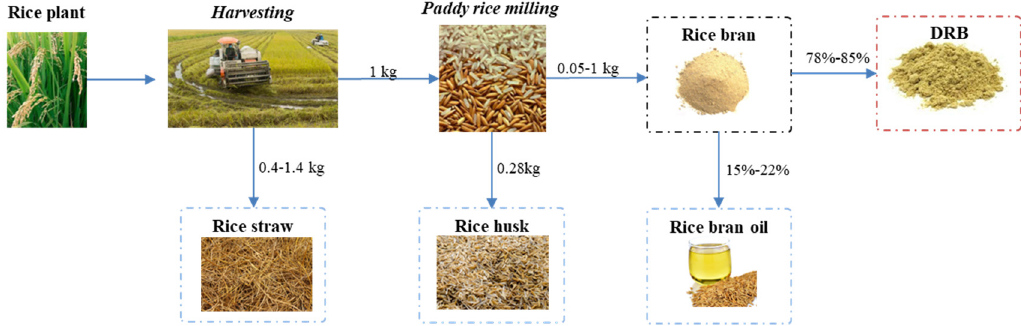
Figure 1. Production of rice and its by-products. Defatted rice bran (DRB) is the residue after the oil extraction from the rice bran accounting for around 78%–85% ( w/w ) of the bran.